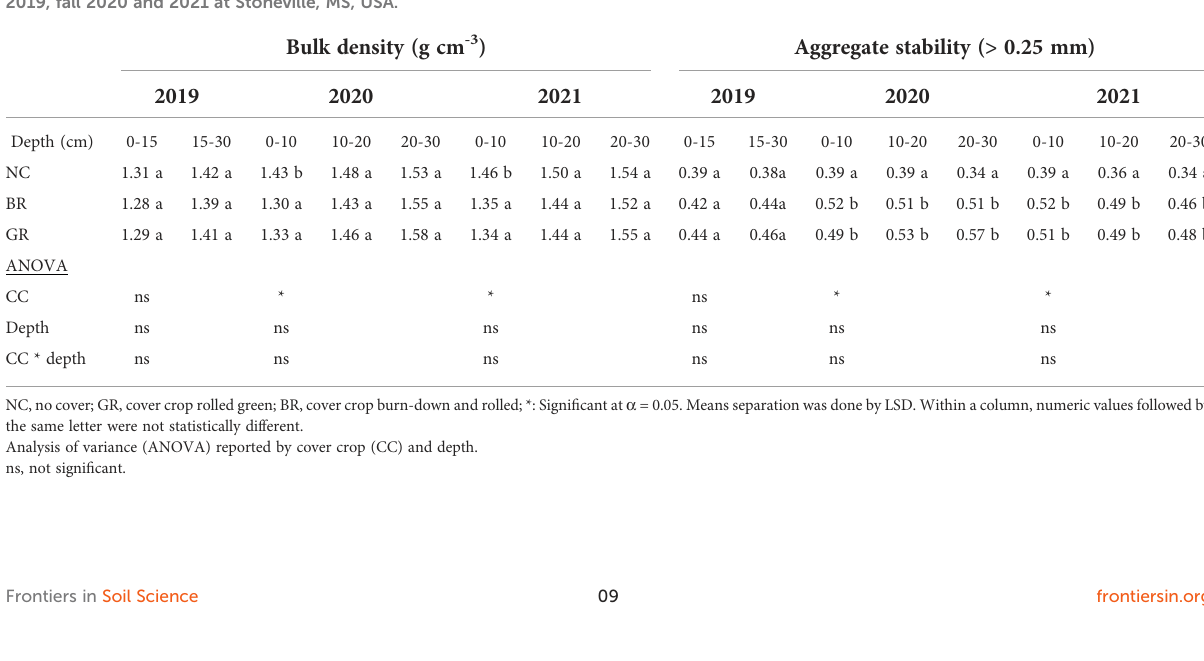
CC rotation and is believed to act as an aggregate binding agent (17). Rye CC had been shown to rapidly increase WSA in soil compared to other physical and chemical properties (40).